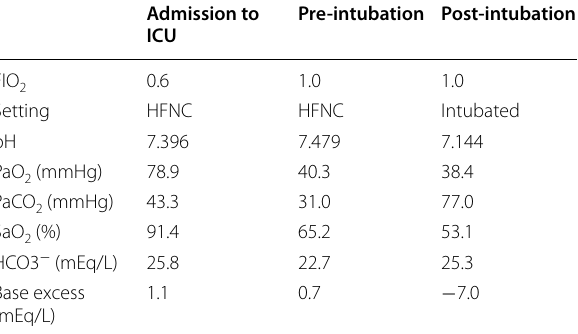
Table 1 Results of arterial blood gas analysis from the time of admission to the ICU until the introduction of